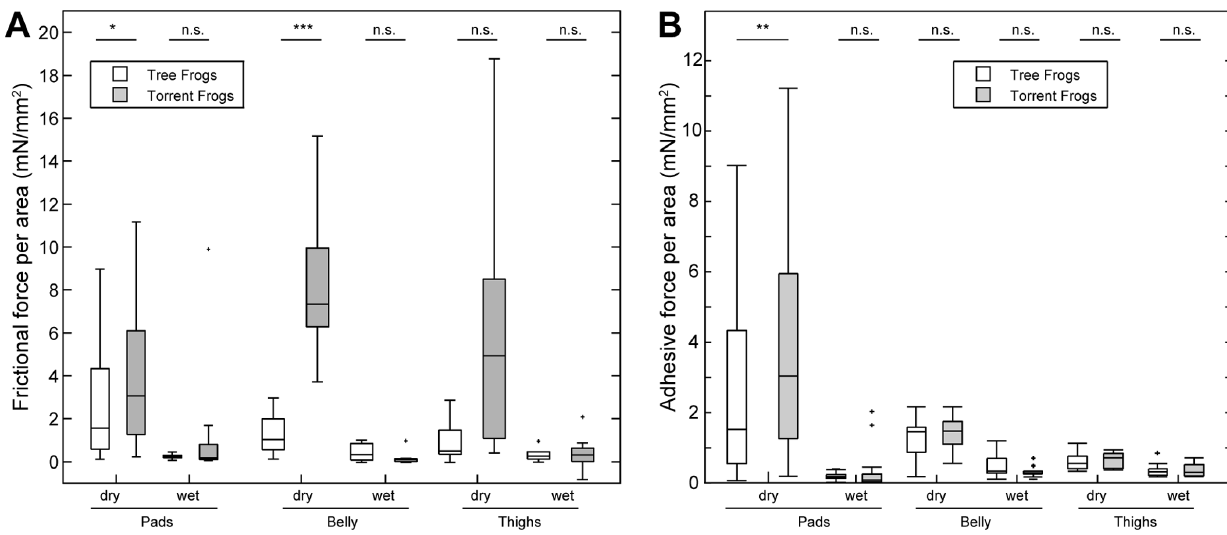
Figure 5. Friction and Adhesion forces per area of different body parts. Statistical differences are denoted as follows: ‘*’ p v 0 : 05 , ‘**’: p v 0 : 01 , ‘n.s.’: not significant.